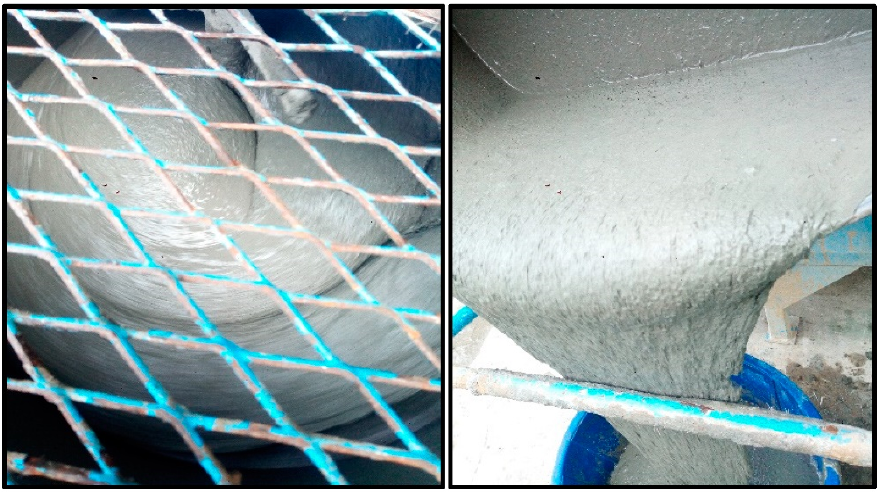
Figure 2. Freshly mixed SC-GORECC.